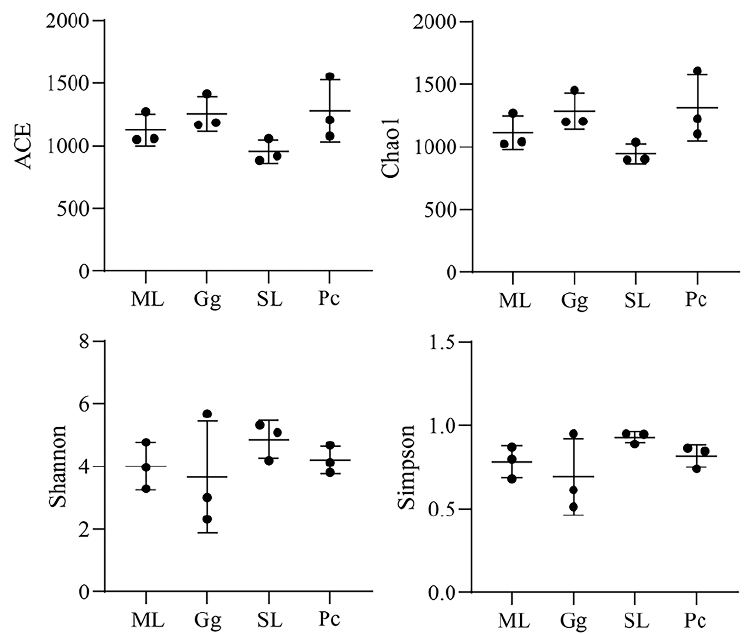
Figure 3. Box plots of ACE, Chao 1, and Shannon and Simpson indexes of gut microbial communities in Locusta migratoria manilensis fed on four different food plants. ML: maize leaves; Gg: goosegrass; SL: soybean leaves; Pc: pakchoi.